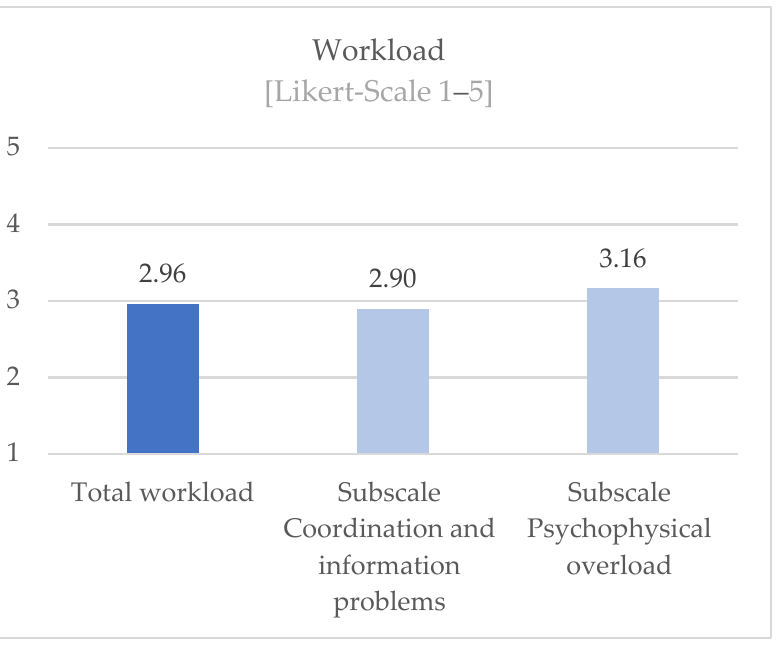
Figure 6. Perceived workload among participants.